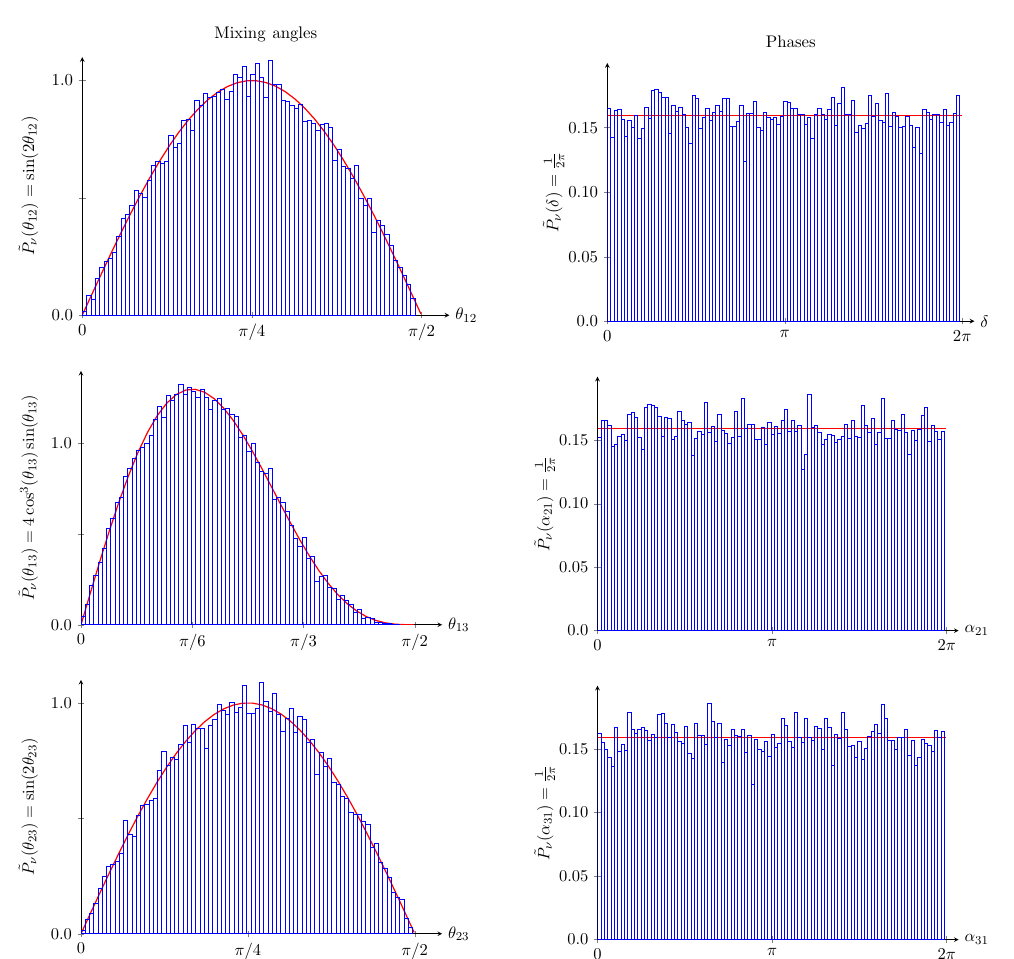
Figure 6 . Probability density functions for the mixing angles and phases of the complex seesaw ensembles with N = 3. The red curve corresponds to the analytic result while the histogram corre- sponds to numerical results (with 2 : 5 10 4 dimensionless light neutrino mass matrices generated). (cid:2) The left and right columns show the mixing angles and the remaining (cid:13)at phases respectively. Since these distributions depend only on the Haar measure of the corresponding Lie group [U(3) in this case], there is no distinction between type I-III and type II seesaw